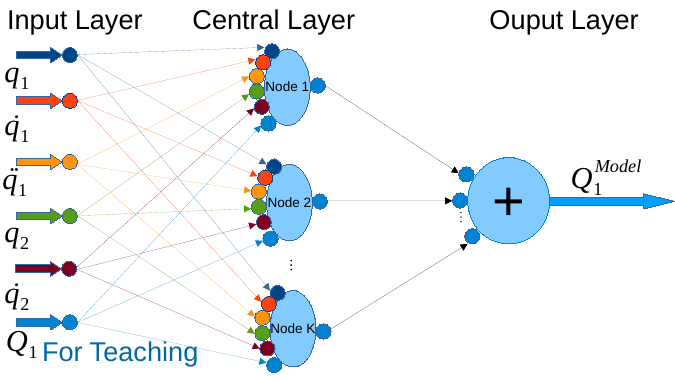
Figure 2. The structure of the suggested rotational neural